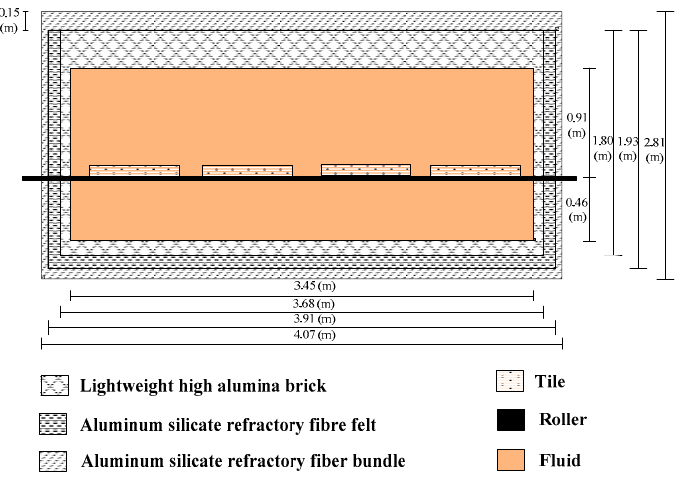
Figure 4. The cross-section of the roller kiln.